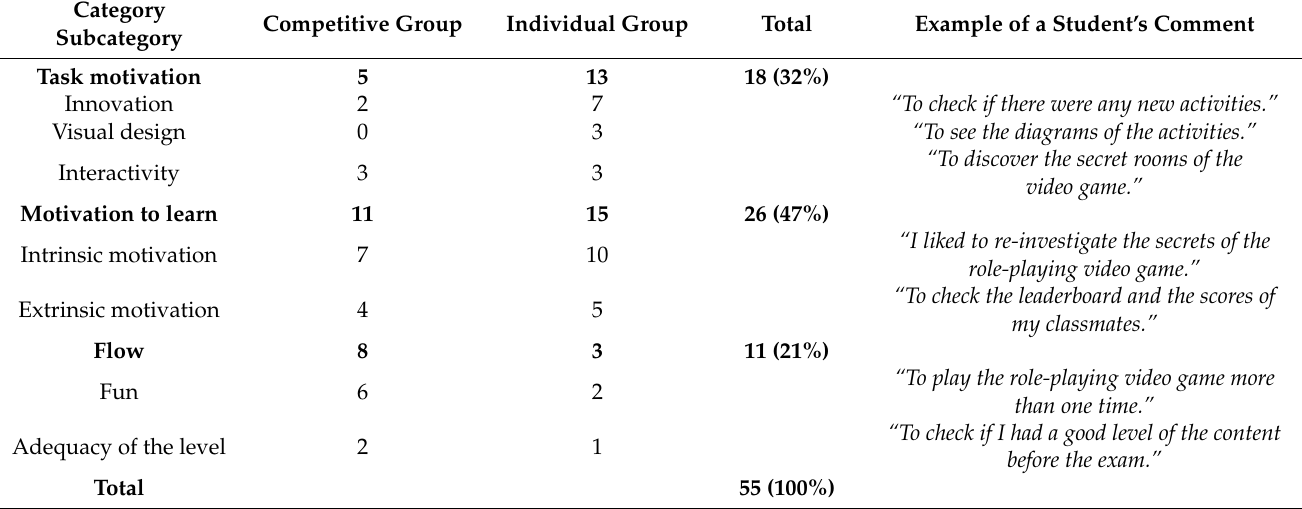
Table 6. Question 3. Comparison between competitive, individual gamifications and comment